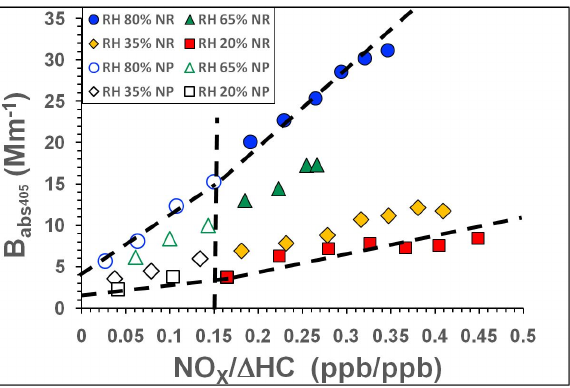
Figure 2. The aerosol absorption coefficient B abs as a function of [NO x ]/[ ∆ HC] at 80% RH, 65% RH, 35% RH and 20% RH. Empty and filled symbols show results for NP and NR SOA, respectively. Dashed lines are included to guide the eye.